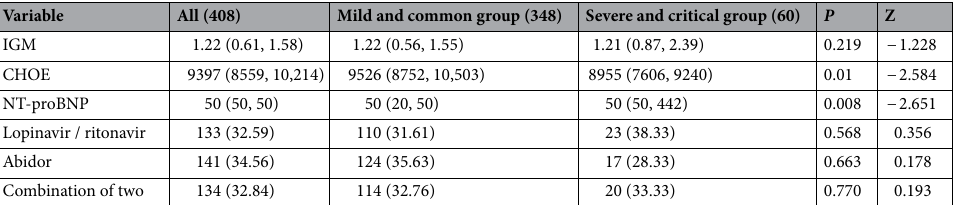
Table 2. Basic characteristics of COVID-19 in mild or common group and severe or critical group in training set. WBC, white blood cell (× 10 9 /L); N, neutrophils (× 10 9 /L); L, lymphocyte (× 10 9 /L); RBC, red blood cell (× 10 12 /L); HB, hemoglobin (g/L); BPC, blood platelet (× 10 9 ); CRP, C-reactive protein(mg/L) ; PCT, procalcitonin (ug/L); LA, lactic acid (mmol/L); ESR, erythrocyte sedimentation rate (mm/h); PT, prothrombin time; INR, international standardized ratio; APTT, partial prothrombin time; TT, thrombin time; FIB, Fibrinogen (g/L); FDP, Fibrinogen degradation products (mg/L); TB, total bilirubin (umol/l); ALT, alanine aminotransferase (U/L); AST, aspartate aminotransferase (U/L); GGT, glutamyl transpeptidase (U/L); ALP, alkaline phosphatase (U/L); ALB, albumin (g/L); GLO, globulin (g/L); PALB, prealbumin (g/L); TBA, total bile acid (umol/L); LDH, lactate dehydrogenase (U/L); HBDH, α-hydroxybutyrate dehydrogenase (U/L); CK, creatine kinase (U/L); MYO, myoglobin; CTnT, troponin (ng/ml) ; CK-MB, creatine kinase isoenzyme; BUN, urea nitrogen (mmol/L); CR, creatinine (umol/L); UA, uric acid (umol/L); GLU, blood glucose (mmol/L); CA, calcium (mmol/L); MG, magnesium (mmol/L); P, phosphorus (mmol/L); FE, iron (umol/L); K, potassium (mmol/L); NA, sodium (mmol/L); CL, chlorine (nnol/L); IGG, immunoglobulin G (g/L); IGA, immunoglobulin A(g/L) ; IGM, immunoglobulin M (g/L); CHOE, cholinesterase (U/L).